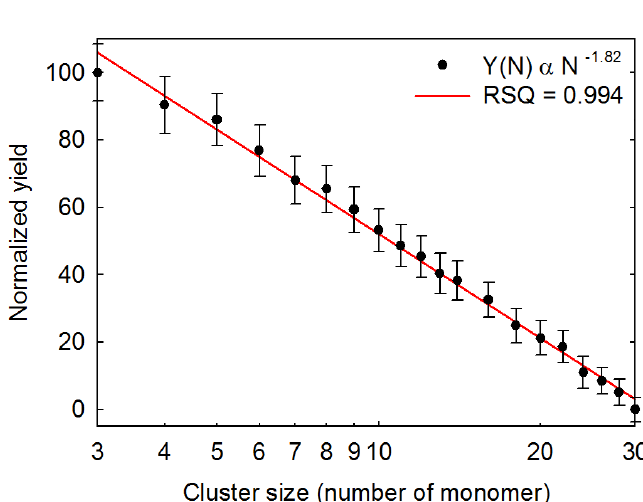
Figure 6. Cluster size distribution of cytochrome c from trimer to 30-mer. The cluster size ( x -axis) and the normalized relative intensity ( y -axis) are plotted on a base-10 logarithmic scale.